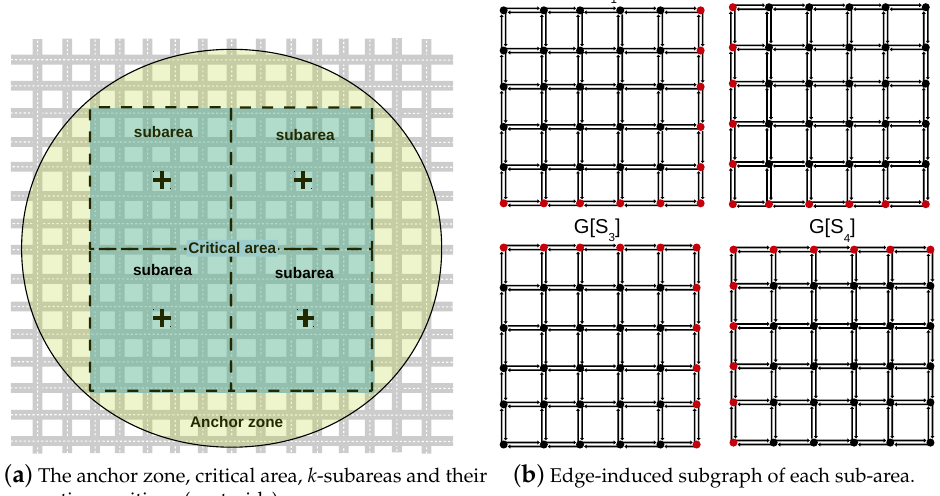
Figure 2. Critical areas, sub-areas, anchor zones and edge-induced